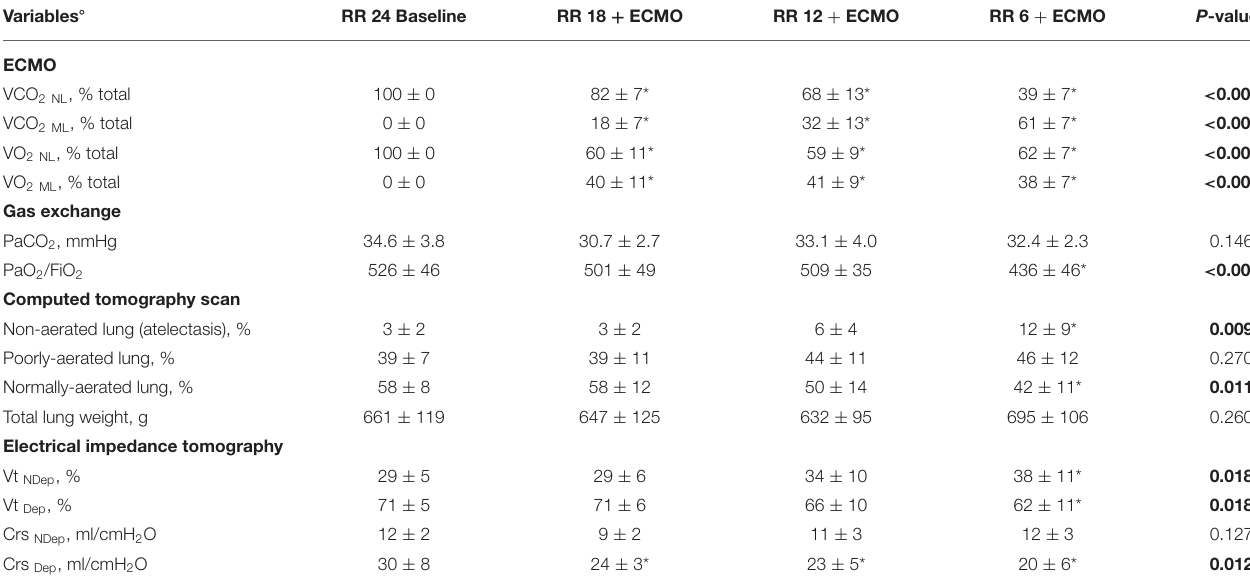
TABLE 1 | Physiological effects of progressive reduction of respiratory rate and increase of extracorporeal CO 2 removal during ECMO support—Part 1. Variables ◦